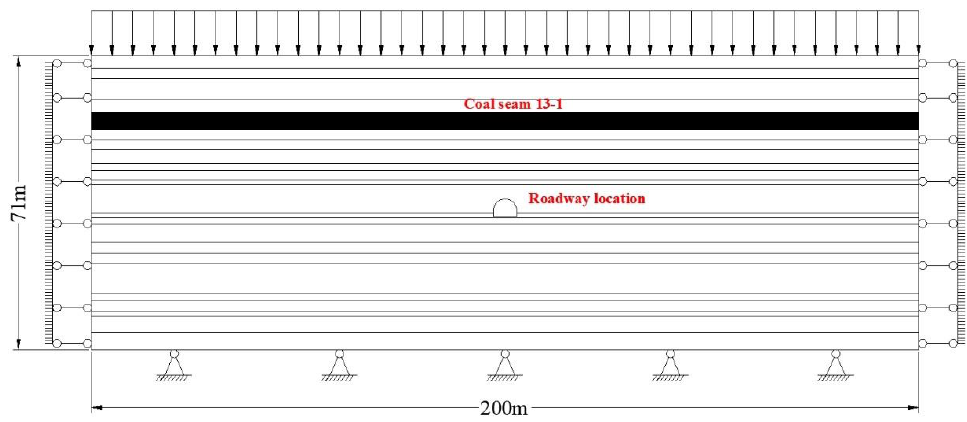
Figure 4. Numerical simulation model. Table 1. Reference table of rock mechanics parameters.